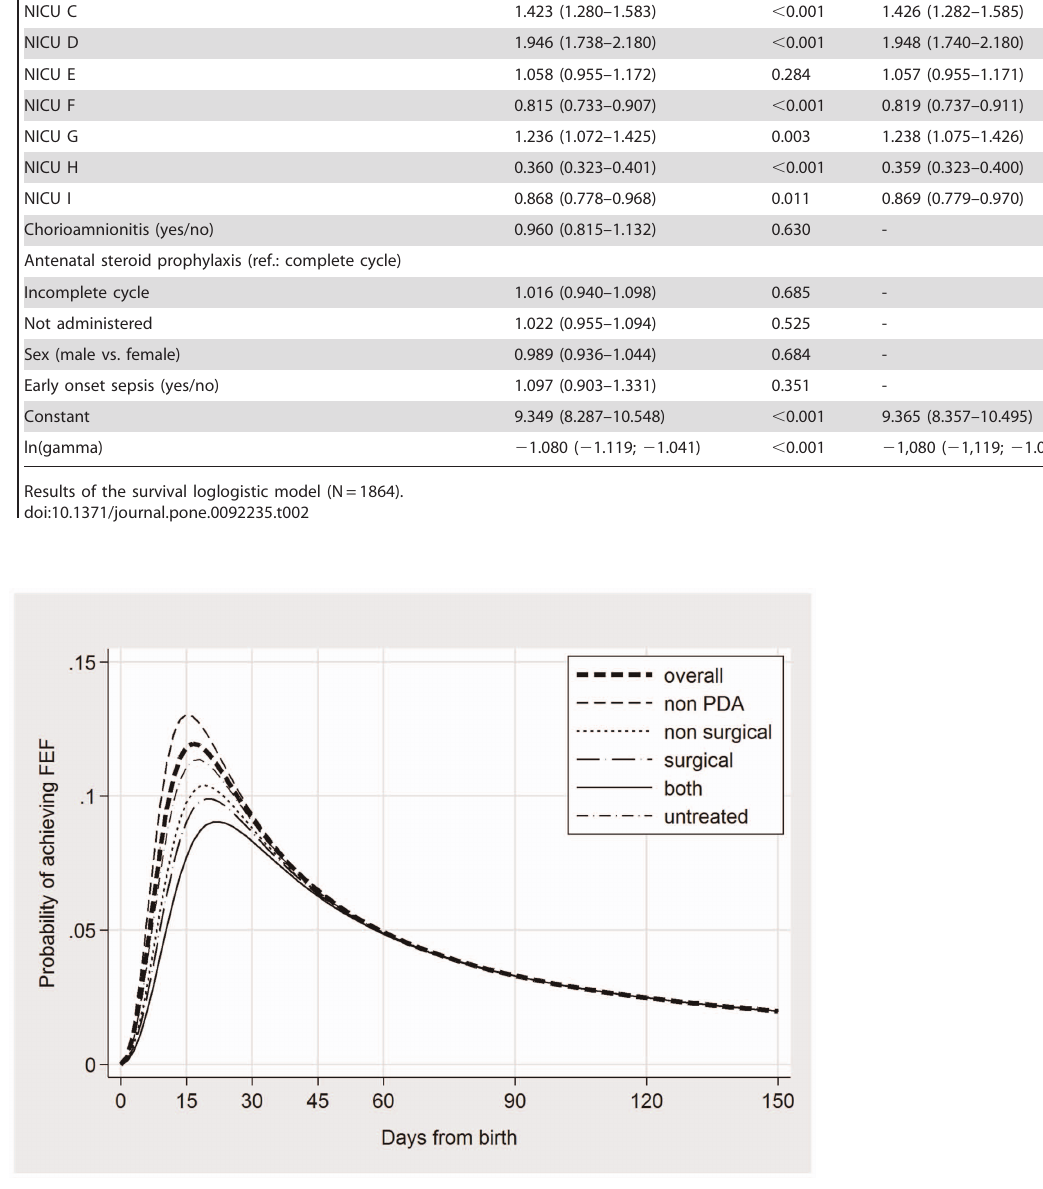
Figure 1. Hazard function of time to full enteral feeding achievement for all newborns (thick line) and for subgroups determined by presence and treatment of patent ductus arteriosus (PDA).